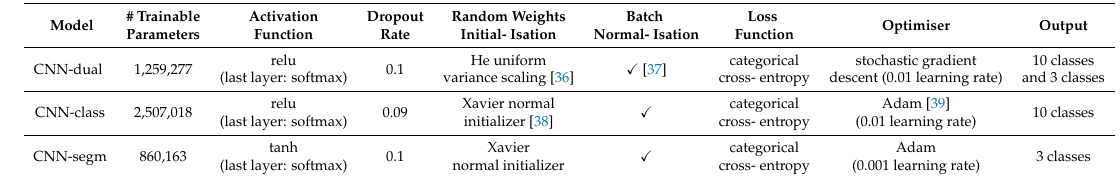
Table 4. Parametrisation of the customised CNN models.